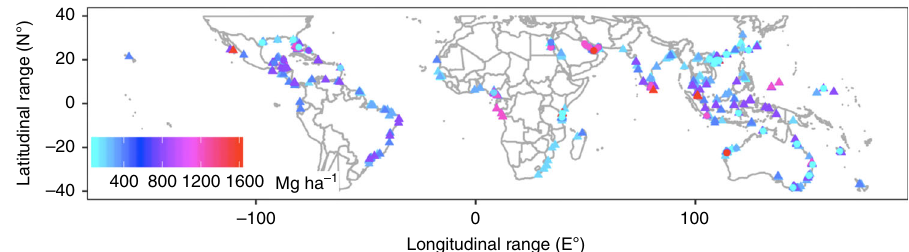
Fig. 3 Global distribution of sediment carbon stocks in mangroves. The triangular and circular labels denote sediment OC and IC stocks, respectively.